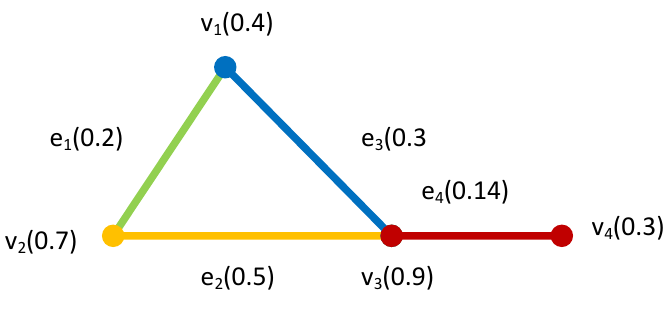
Figure 2.1: Color class of a fuzzy graph 𝐺